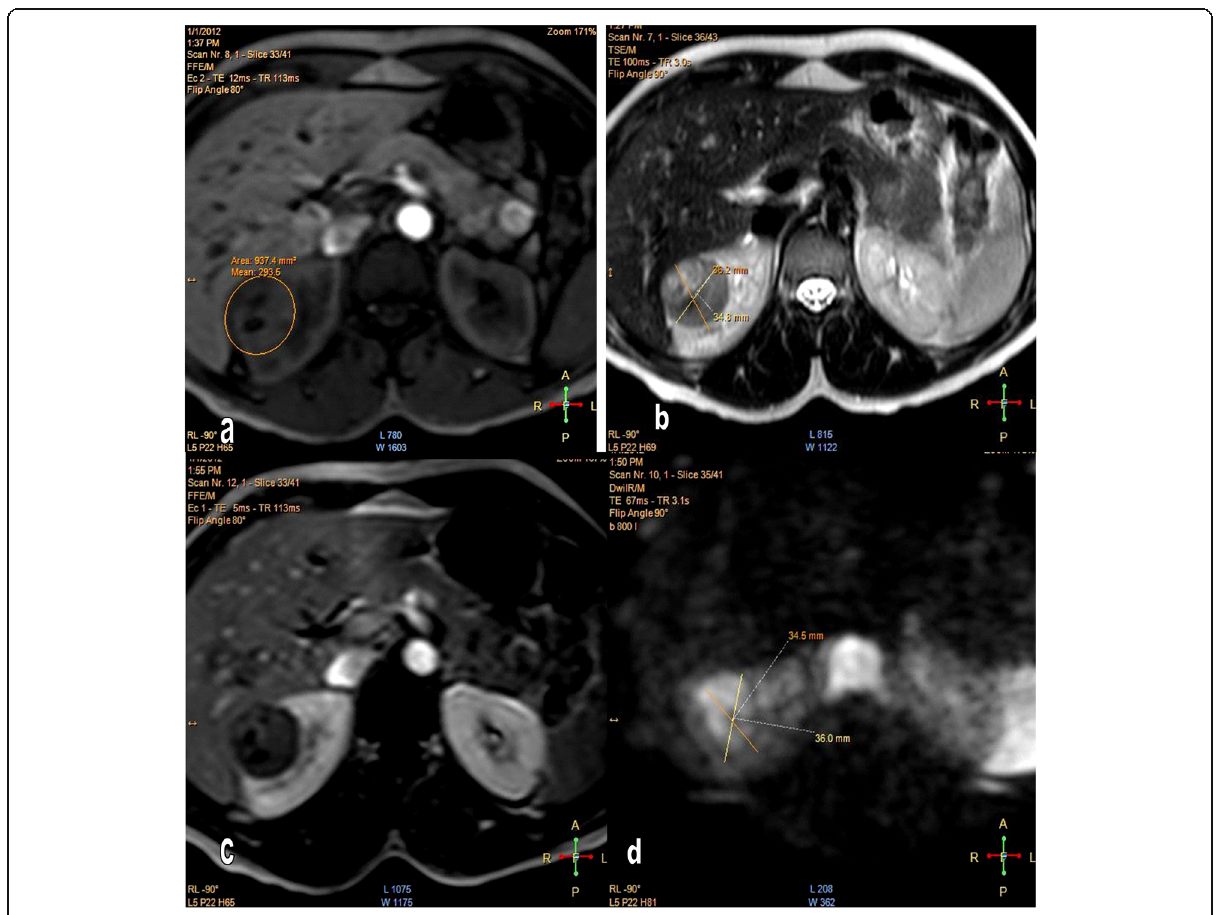
Fig. 3 Male patient, 64 years of age, evidence of large upper polar right kidney solid mass lesion with infiltrative growth (arrow), displaying low signal in T1 and high signal in T2 ( a , b ), showing moderate enhancement after IV contrast administration and restricted diffusion on DWI; the ADC value was 1.2 × 10 − 3 mm 2 /s ( c , d ), and papillary RCC was pathologically confirmed after radical